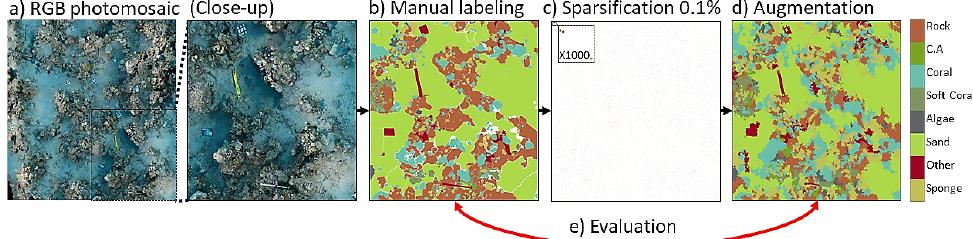
Figure 5. Augmentation validation workflow. ( a ) A 5 × 5 m 2 photomosaic from the RS data-set. ( b ) The mosaic was fully labeled manually according to the eight classes in the colour code (right). ( c ) The full labels were sparsified (the example depicts the remaining 0.1% pixels and a magnification of the top left corner). ( d ) The sparse labels were augmented using our method, and ( e ) evaluated against the full manual